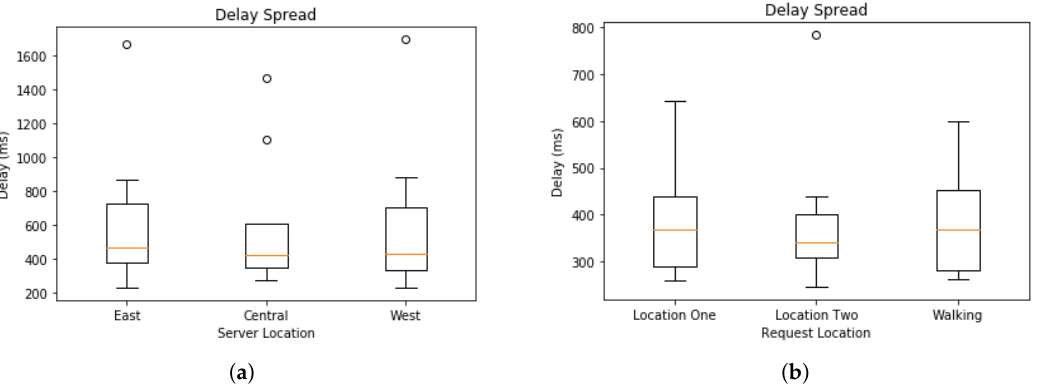
Figure 11. Analysis of delay spread with high fliers shown. ( a ) Analysis of delay spread for intersection encounter requests sent to the “east”, “central”, and “west” servers. ( b ) Analysis of delay spread from a mobile device with requests being made while stationary at locations one and two and while walking between the two